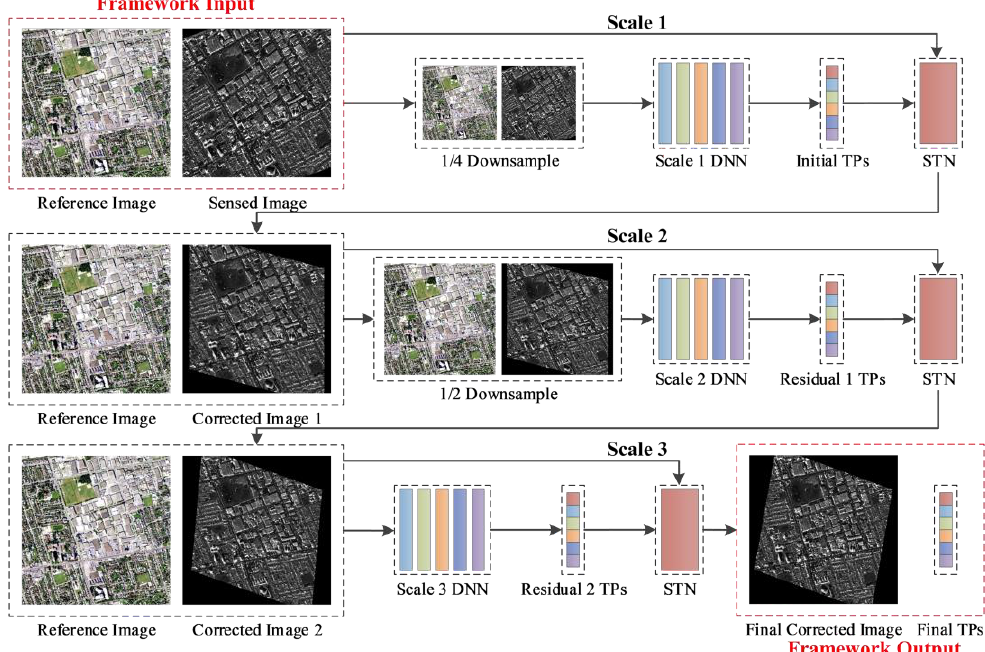
Figure 2. Multiscale workflow for